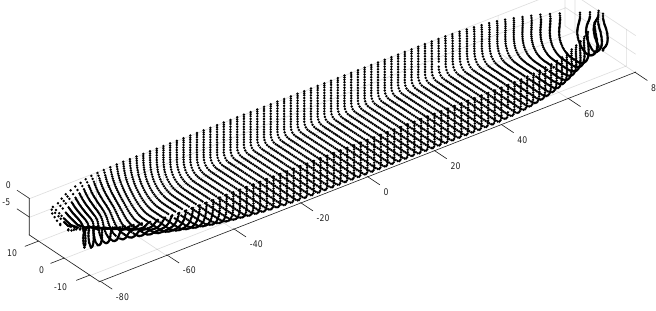
Figure 17. Dense body plan of a real bulk carrier (80 slices).